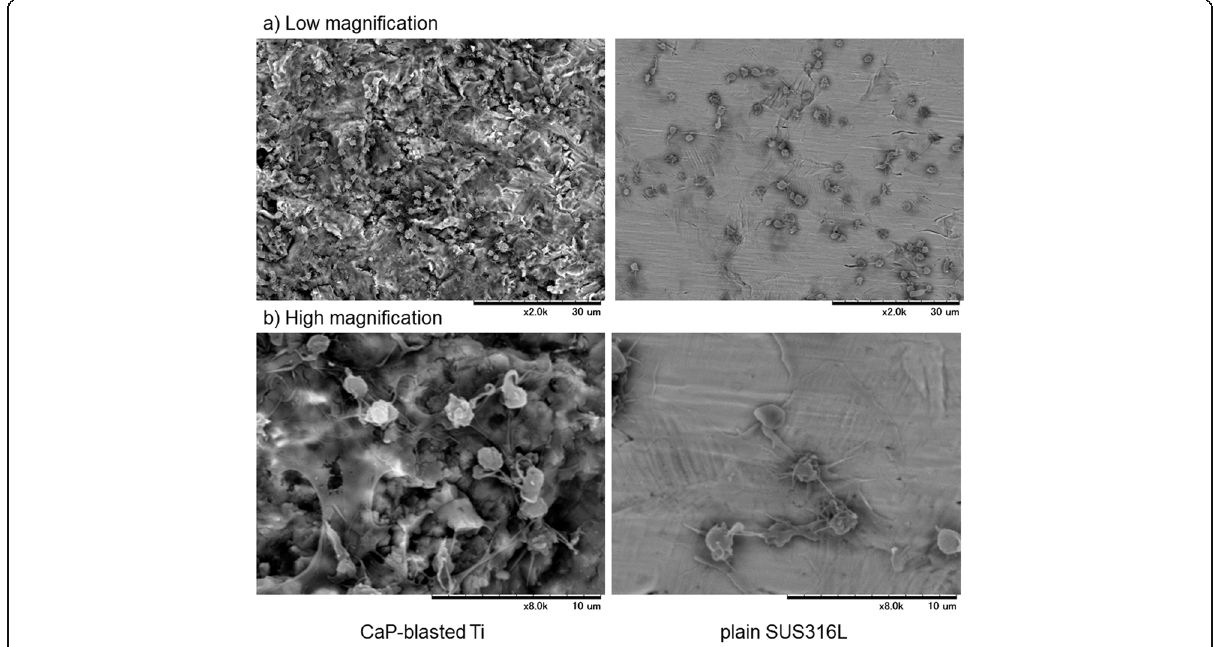
Fig. 7 SEM observations of platelets adherent on CaP-blasted cp-Ti and plain SUS316L plates. PRP was placed on the plates, incubated for 60 min, washed, fixed, and dehydrated for SEM examination. a Low magnification and b high magnification